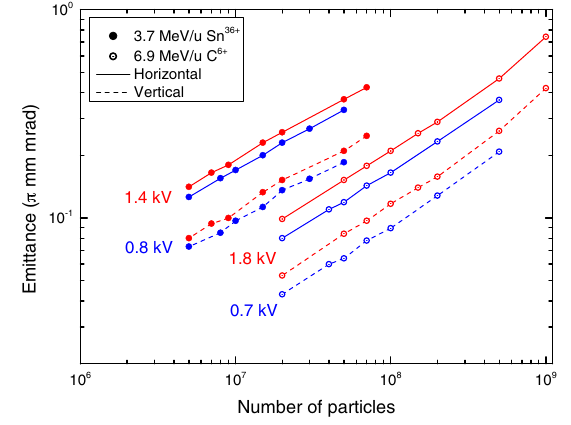
FIG. 6. The dependence of the beam emittance on particle number for the beam 112 Sn 36 þ and 12 C 6 þ in the simulation.